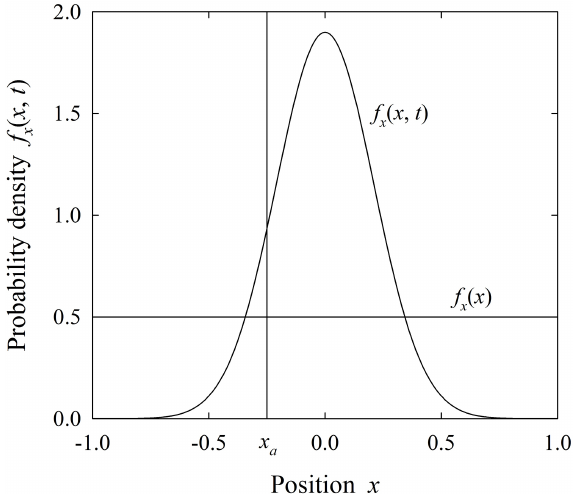
Figure C1. Plot of coordinate position x of particle undergoing a random-walk motion showing Gaussian distribution f x ( x,t ) of ex- pected positions at time t as the solution, Eq. (C2), of the Fokker– Planck equation, and the actual (example) particle position x = x a , and uniform steady-state distribution f x ( x ) = 1 / 2 for a bounded domain such that − 1 < x < 1. Figure reproduced from Furbish et al. (2018c).